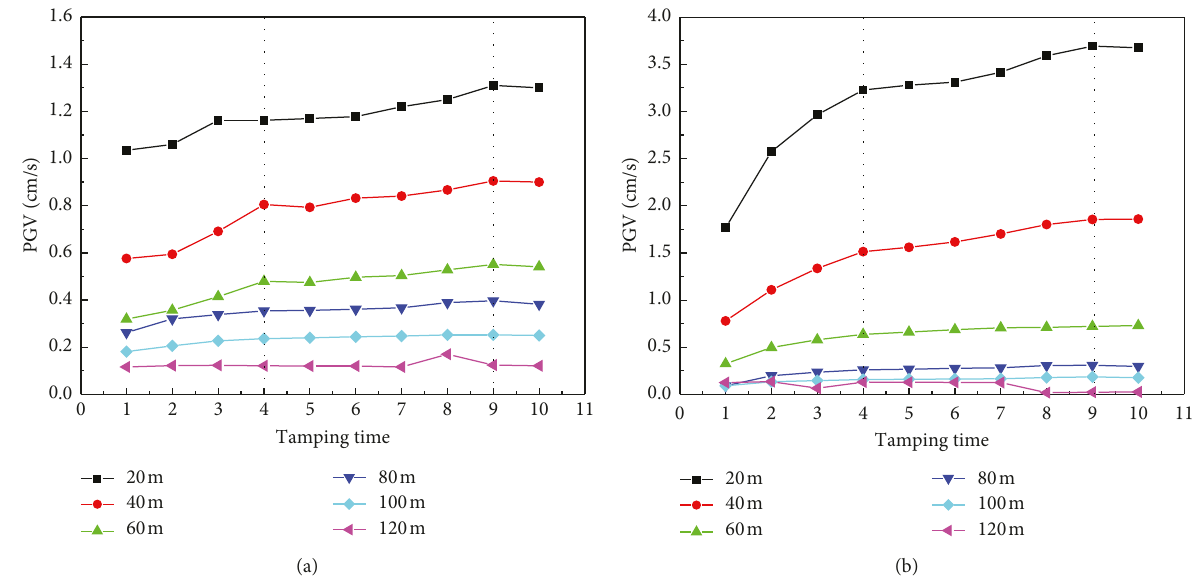
Figure 6: Relations between PGV and tamping times at different measured distances. (a) In radial direction. (b) In vertical